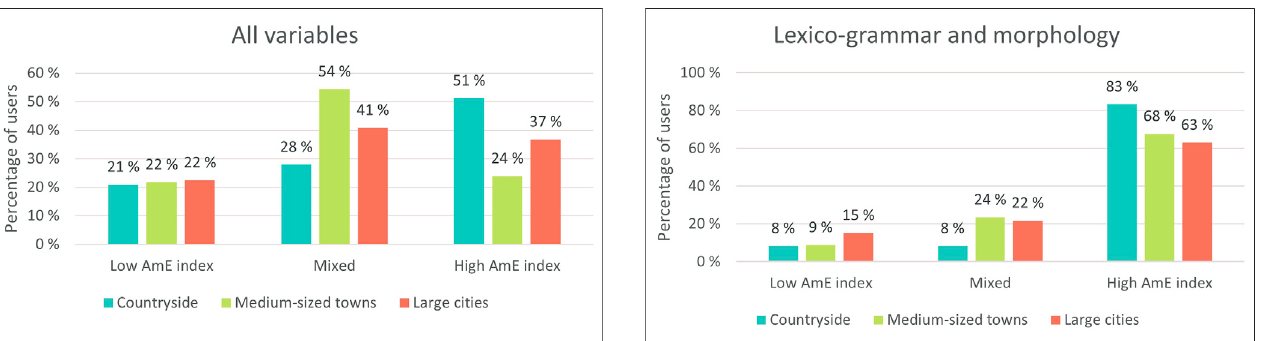
FIGURE 9 | Variation of AmE features in idiolects divided based on geographical location.